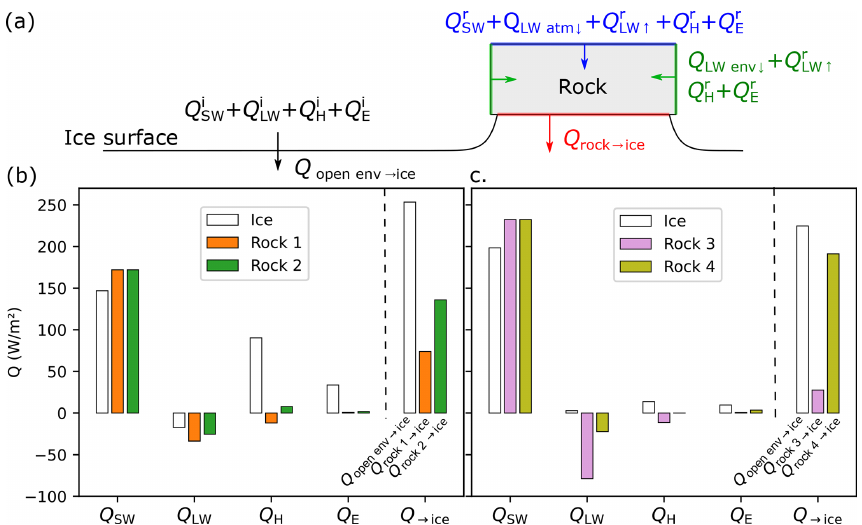
Figure 5. (a) Schematics of the heat fluxes considered in the models for the ice surface melting (left) and glacier table formation. The colours denote the surfaces on which the fluxes are received. (b, c) Distribution of the heat fluxes averaged over the duration of observation as predicted by the time-resolved model for the ice surface (white) and for the four rocks studied (coloured).